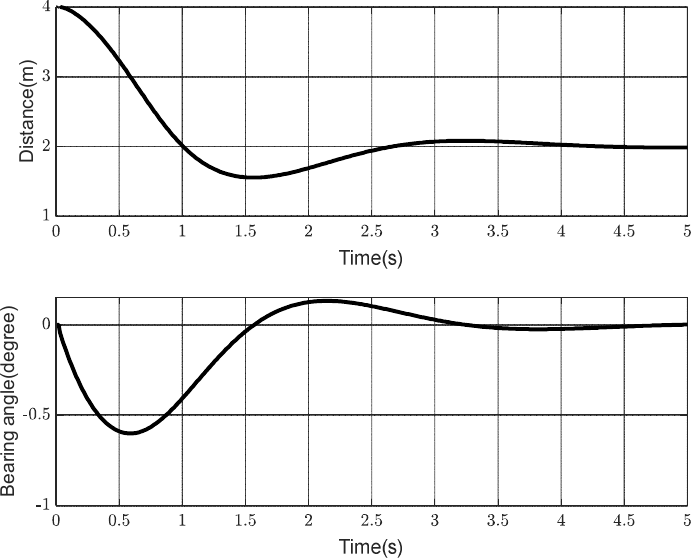
Figure 10. Formation distance and bearing angle variation of the optimized model (desired following position set at (2 m , 0 ◦ )).